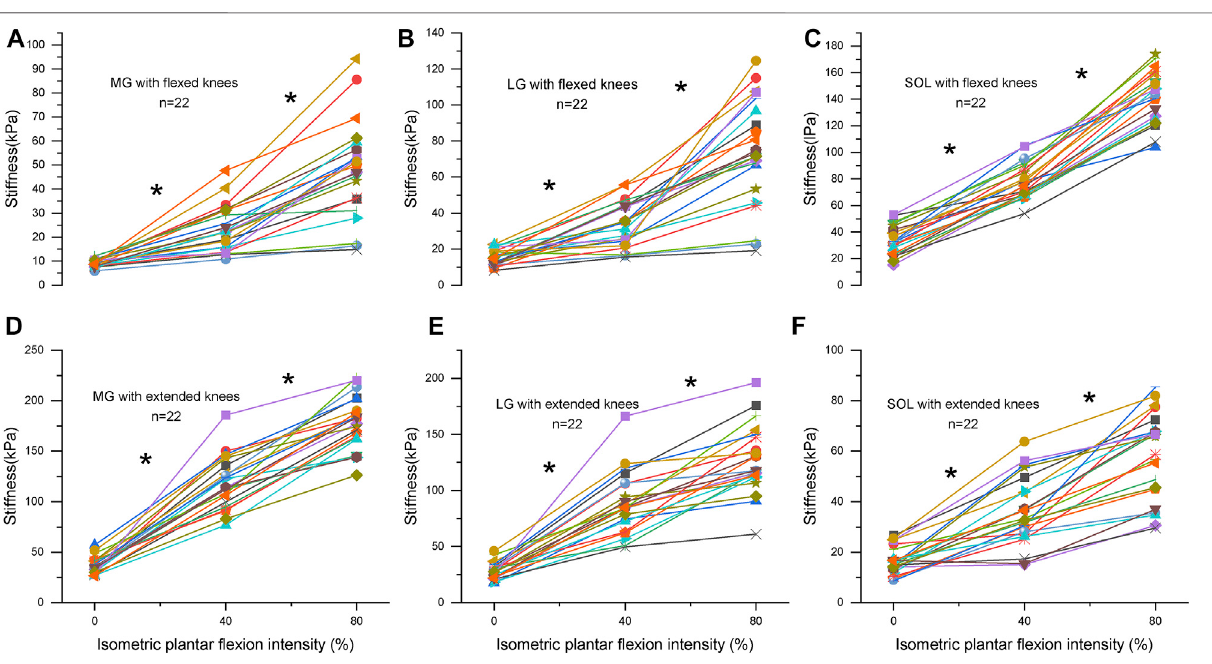
Frontiers in Bioengineering and Biotechnology |